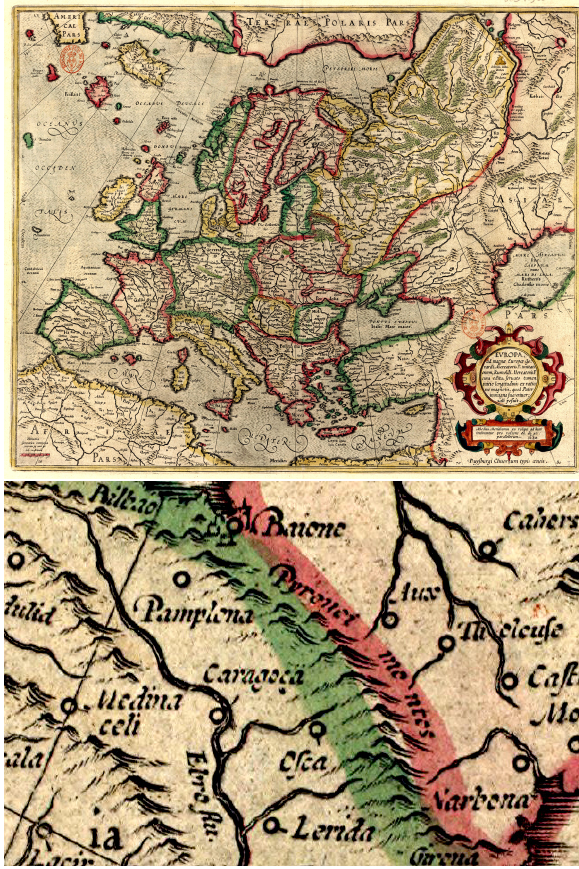
Figure 6: Unknown cartographer, 1630, Europa : Two-colour bor- der